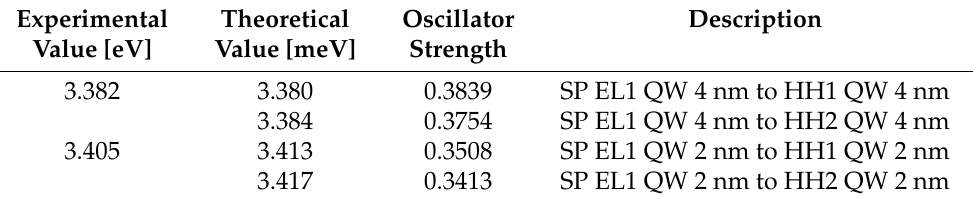
Table 5. Single particle (SP) energy transitions, oscillator strength both calculated in 8 k·p model and corresponding experimental values for structure #3: 2 QWs with widths 2 and 4 nm and 2.5 nm barrier between them.